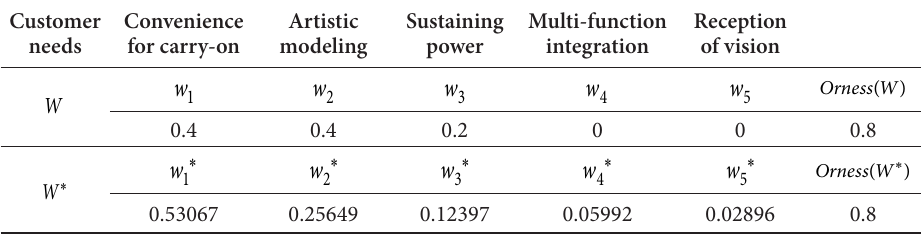
Table 2. The aggregation weighted vector W and W ∗ for fuzzy linguistic quantifier “At least half” Customer needs